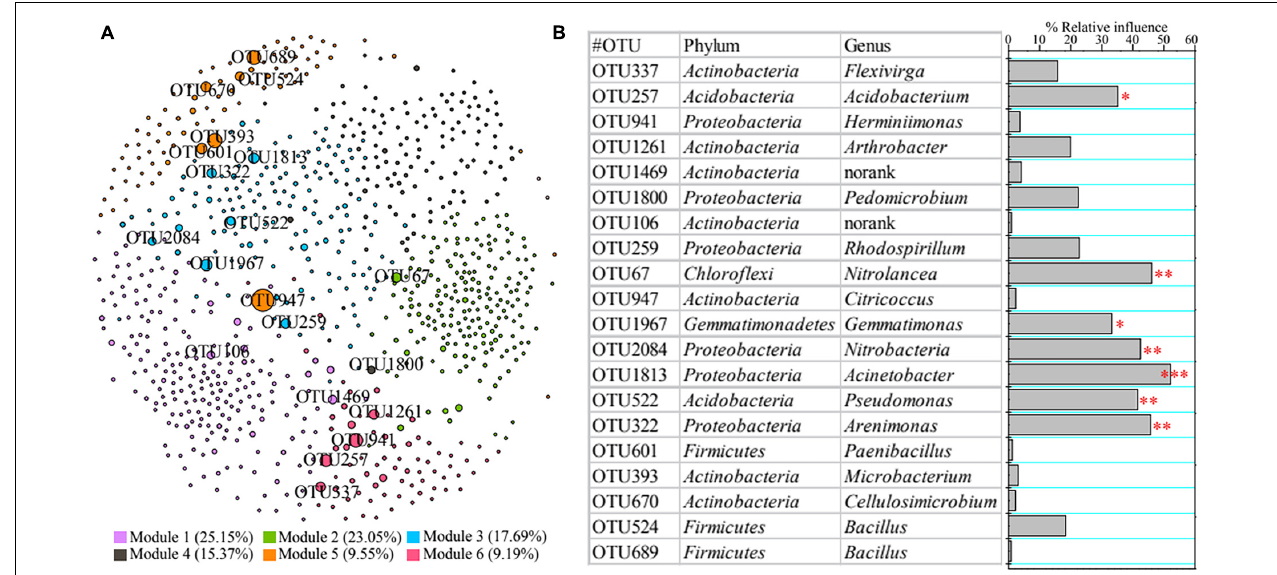
FIGURE 4 | Co-occurrence network of rhizosphere bacteria (A) and contributions of core taxa to vegetation property based on permutational multivariate analysis of variance (PERMANOVA) (B) . Asterisks denote significance ( ∗ p < 0.05; ∗∗ p < 0.01; ∗∗∗ p <